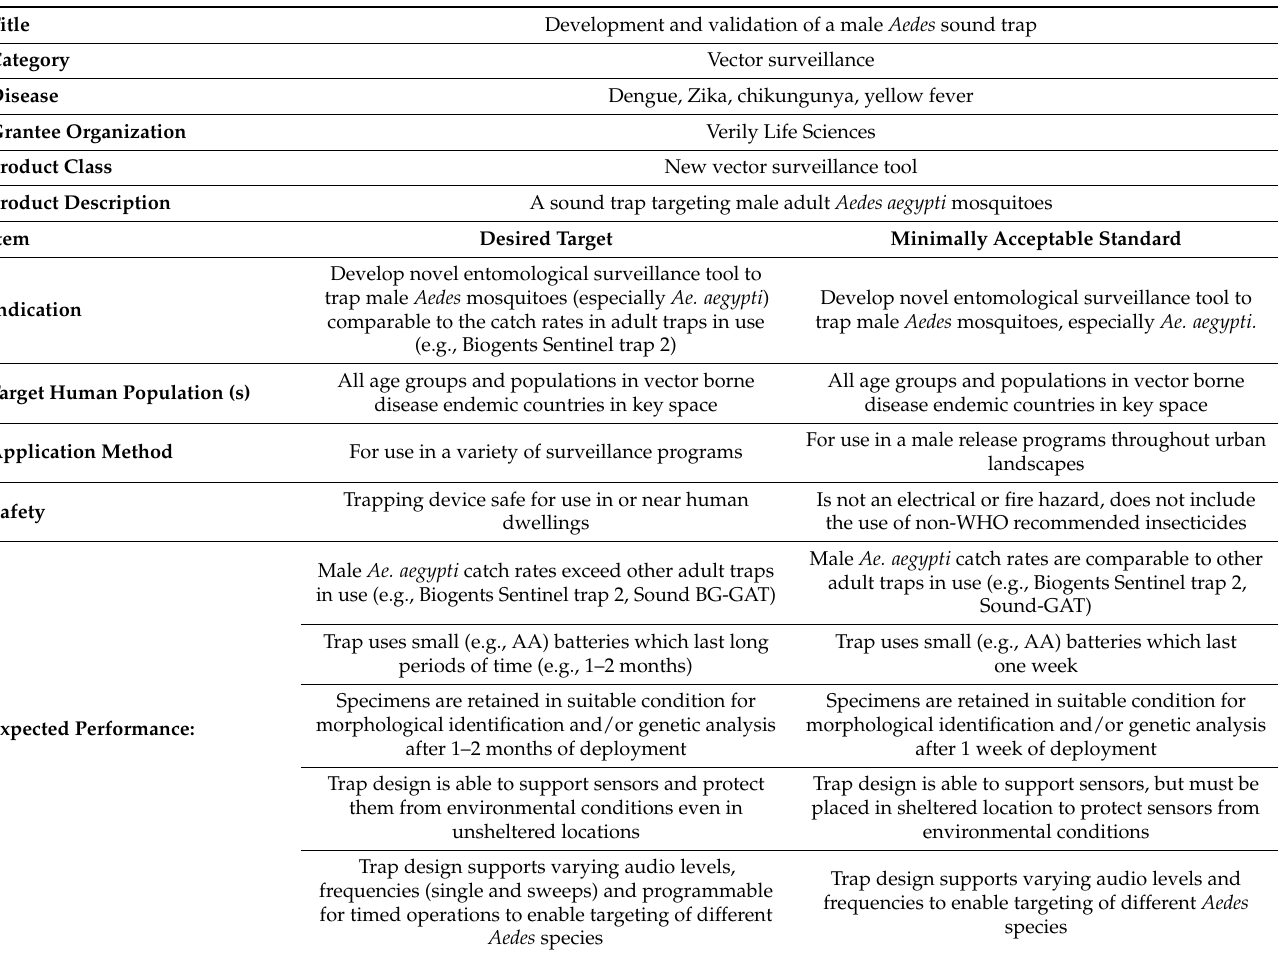
Table 1. Target product profile for the development and validation of the male Aedes sound